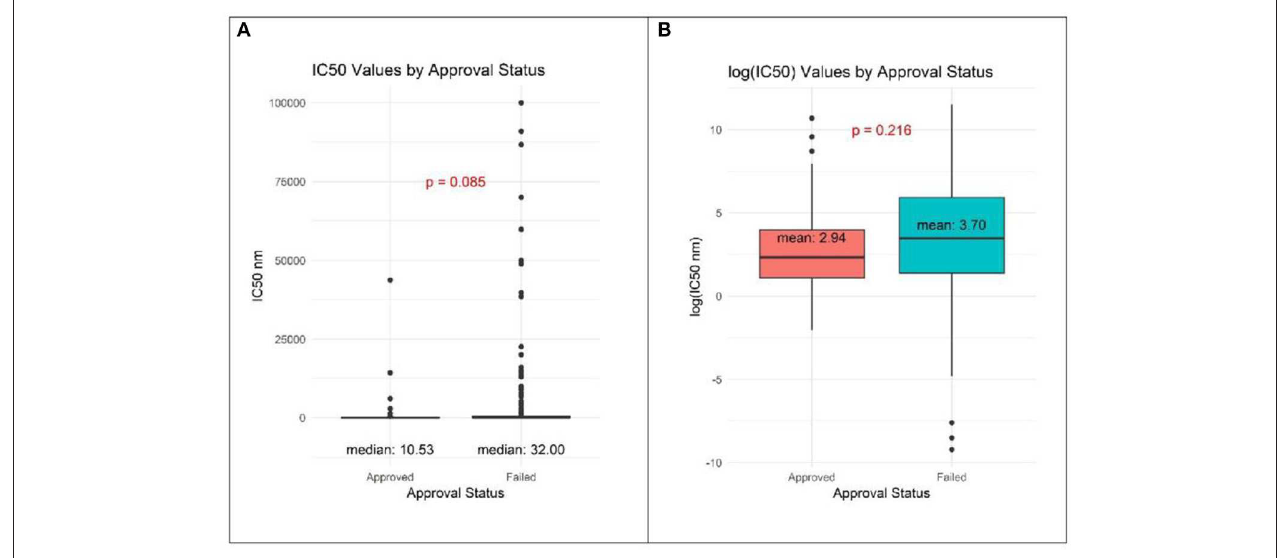
FIGURE 1 | Distributions of IC50 values in preclinical cell line experiments among drugs that were subsequently approved or failed. (A) IC50 values and (B) log (IC50)